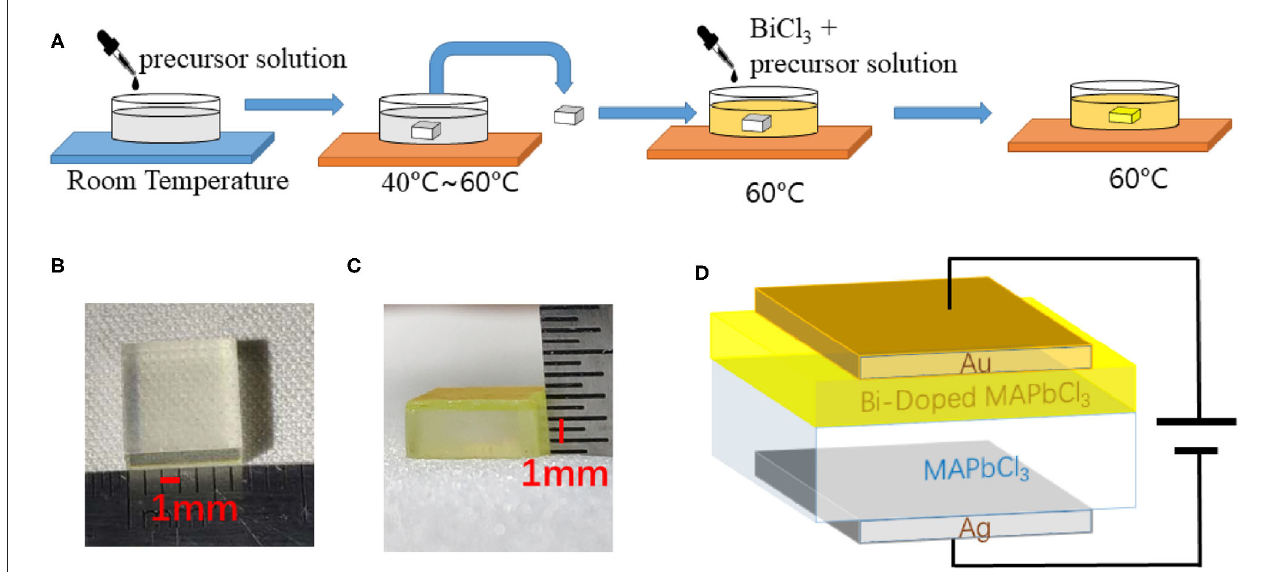
FIGURE 1 | (A) Processing of the growth of PSC and epitaxial. (B) Optical photo of pristine MAPbCl 3 PSC. (C) Optical photo of MAPbCl 3 single crystal with Bi-doped MAPbCl 3 epitaxial layer. (D) Schematic representation of the photodiode